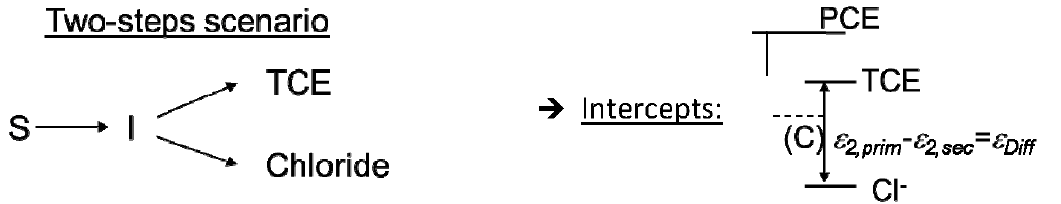
Figure 5. Interpretation of chlorine isotope data in a two-step scenario with respect to intercepts between PCE, TCE and chloride of the applied mathematical